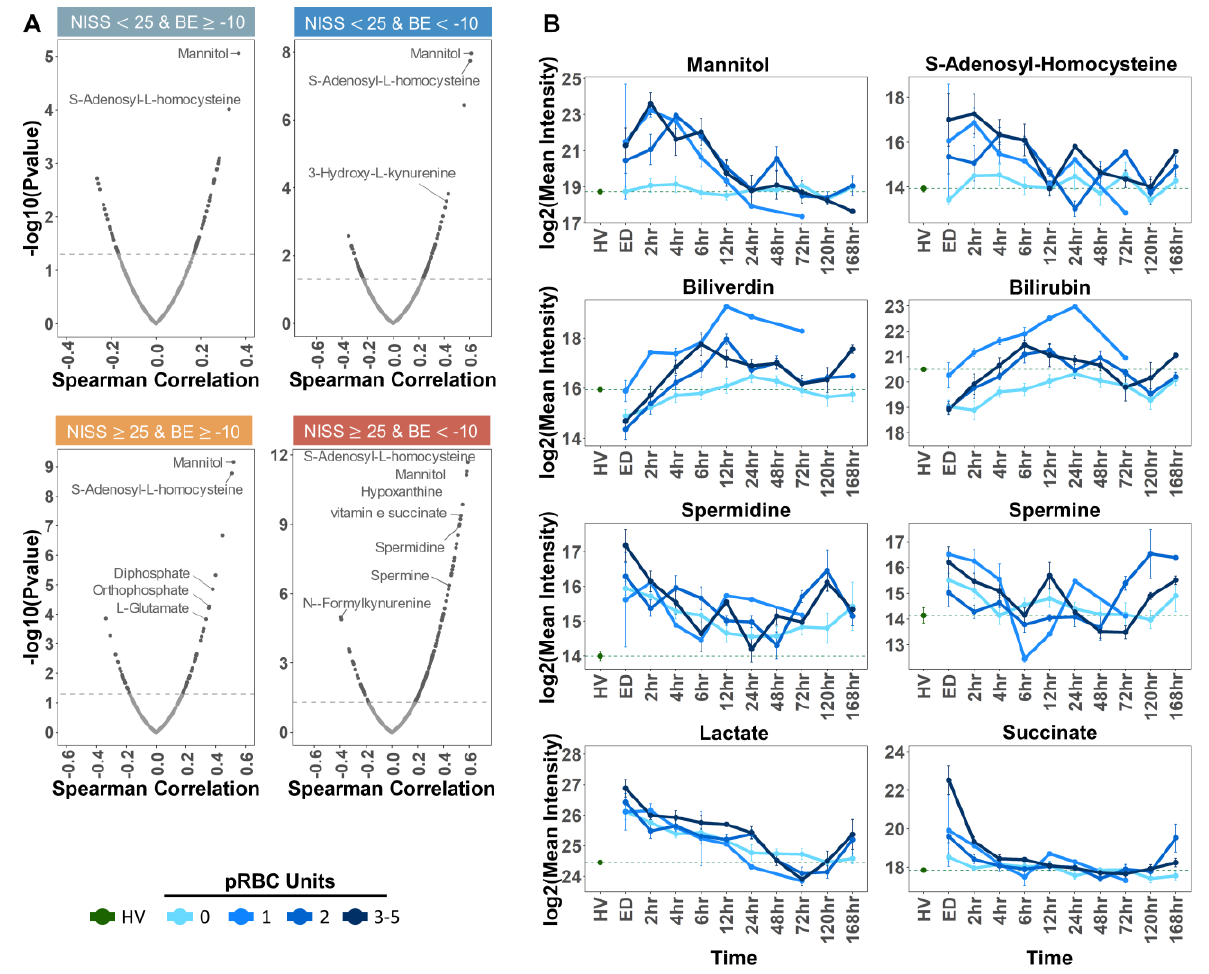
Figure 2. Metabolite correlates to pRBC transfusion Spearman correlations of total pRBC units with all detected metabolites ( A ). Correlations were performed per severity group as indicated by BE and NISS cut-off values labeled above each plot. Patient samples at the ED time point were used for the correlations. The Spearman correlation values were plotted on the x-axis, and − log10 transformed p values were plotted on the y-axis. The dashed horizontal line indicates the significance threshold, − log10(0.05). Temporal trends of top significant metabolite correlates are shown in panel ( B ). The dashed green line indicates the log2 transformed mean healthy volunteer (HV) intensity. Patients were grouped by number of pRBC units received (0, 1, 2, or 3 – 5). The log2 transformed mean patient intensity was plotted at each time point from ED to 168 h per group. Bars represent the standard error at each time point.